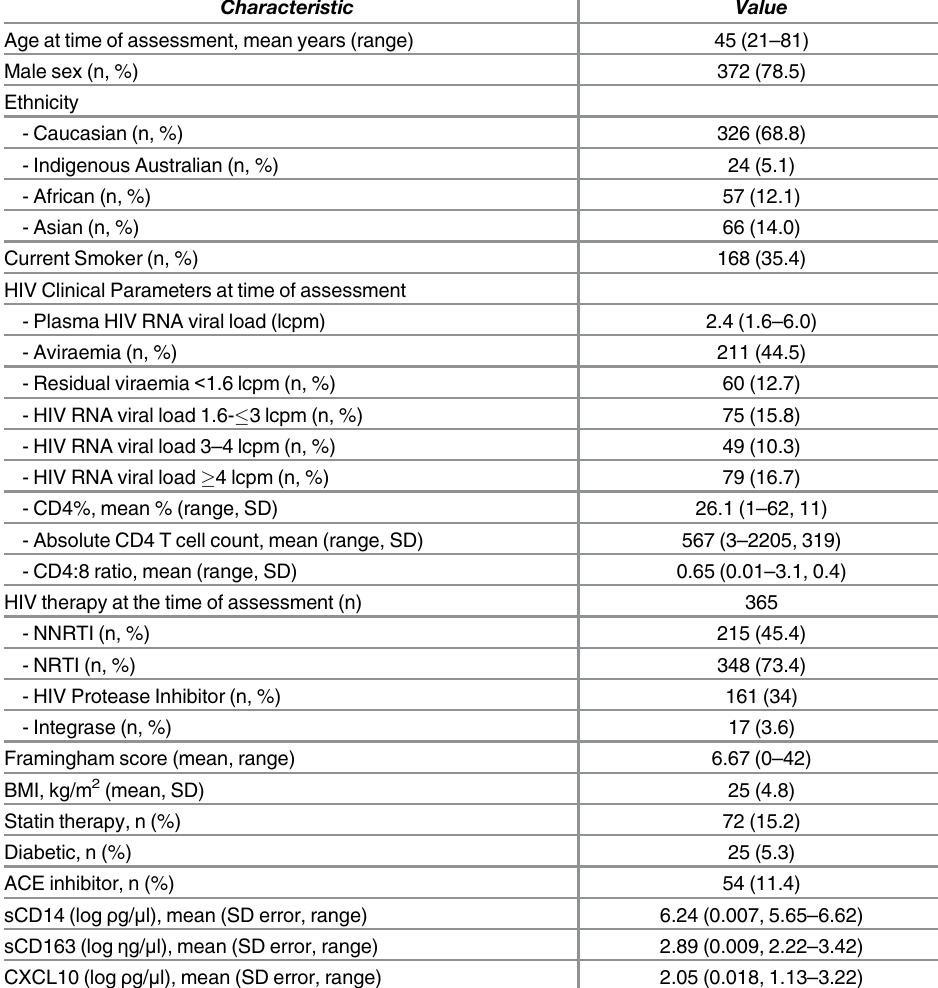
Table 1. Demographics and patient characteristics from 474 HIV positive patients who underwent CVD risk assessments in 2010. Characteristic